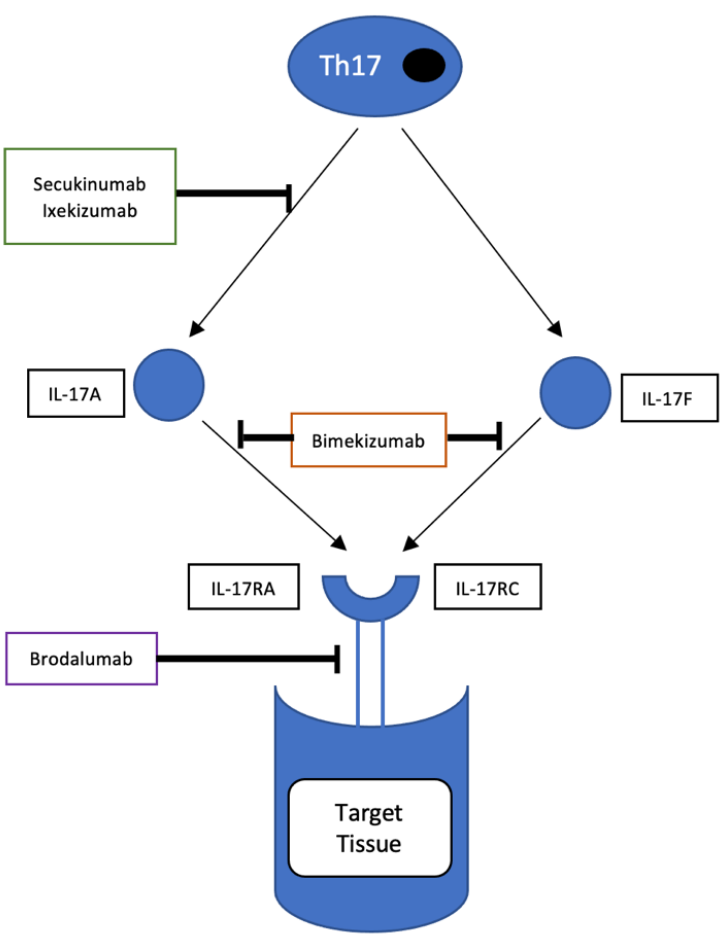
Figure 2. Mechanism of action of IL-17 inhibitors. Secukinumab and ixekizumab bind to IL-17A and inhibit its interaction with the IL-17 receptor. Bimekizumab binds to Il-17A and IL-17F and inhibits the activation of the IL-17RA/RC complex. Brodalumab binds to IL-17RA and blocks the actions of IL-17A,E,F.